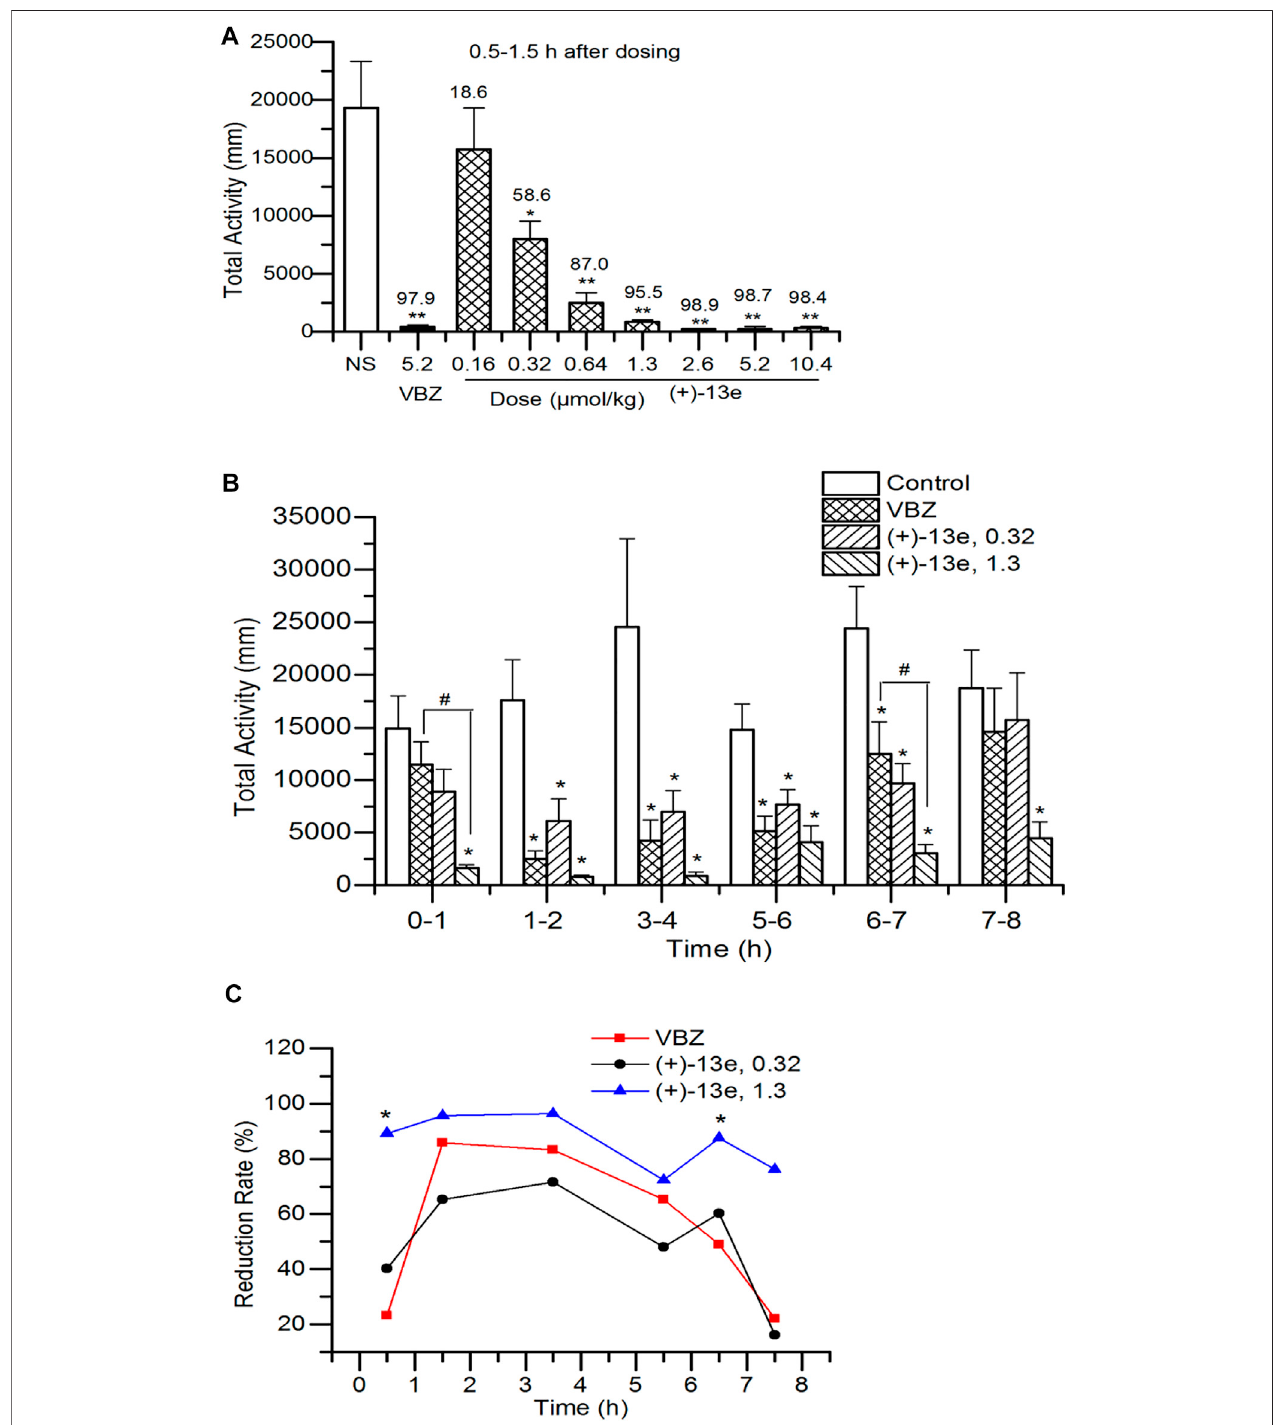
FIGURE 3 | Locomotor activity in Sprague – Dawley rats after a single intragastric dose of (+)-9-tri fl uoroethoxy- α -dihydrotetrabenazine [(+)-13e] (A) Dose- dependent effects were assessed using the distance of locomotion at 0.5 – 1.5 h after administration, and the upper value of the histogram was the reduction rate of locomotion (%) (B) Time-dependent effects were evaluated using the distance of locomotion at different periods after administration of (+)-13e at 0.32 and 1.3 μ mol/kg, taking valbenazine (VBZ) as control at oral dosing of 1.3 μ mol/kg (C) The time – effect relationship of the reduction rate of locomotion. The results are expressed as the mean ± SEM, n (cid:1) 12/group. * p < 0.05, ** p < 0.01, compared with the NS group. # p < 0.05, compared with VBZ group.